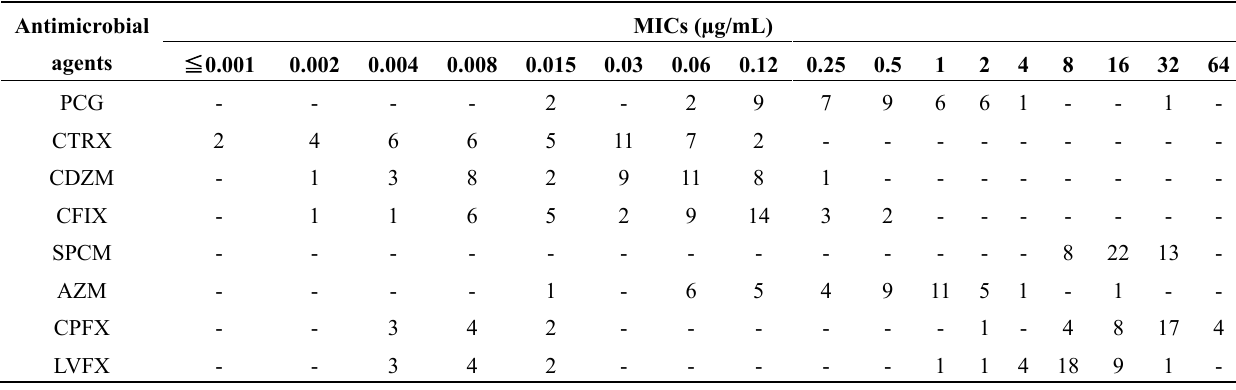
Table 1. The MIC distribution of each antimicrobial agent against 43 clinically isolated N. gonorrhoeae